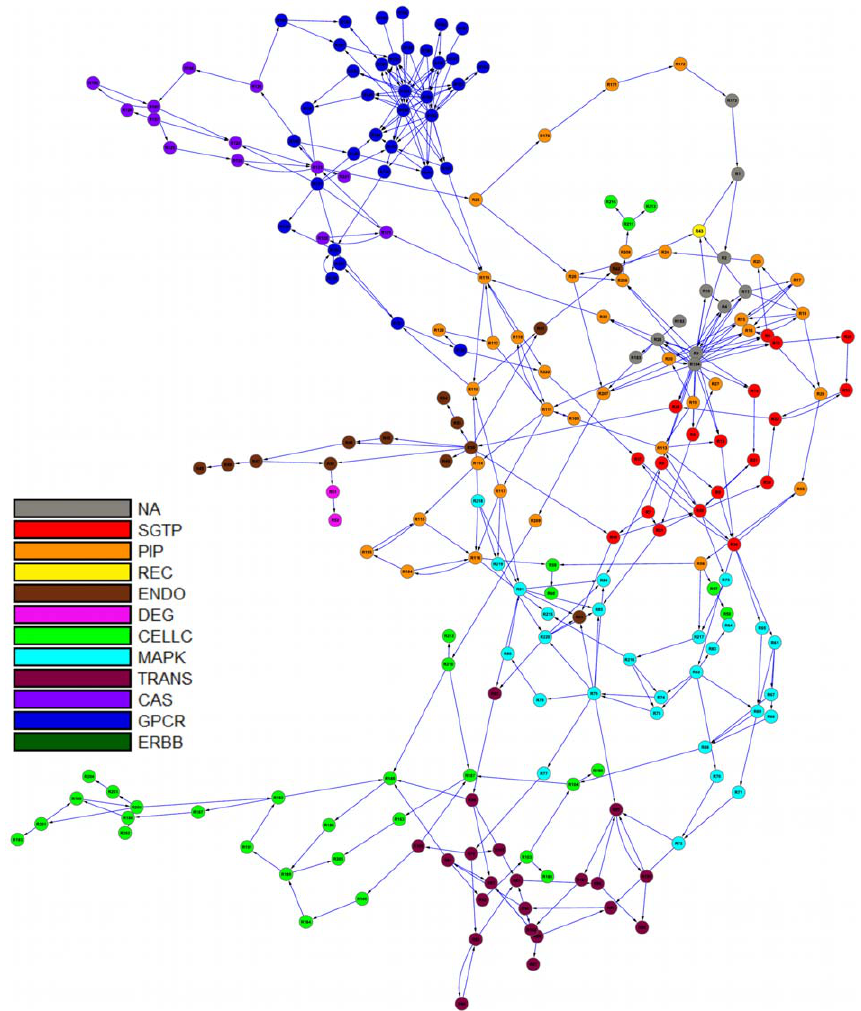
Figure 1. Graph image of the signaling network. Each reaction in the network was a priori assigned to one of 11 canonical signaling pathways as described in Methods. The pathway assignments are indicated by the color of the reaction vertex in the network. (NA: not assigned; SGTP: small guanosine triphosphatase mediated signaling; PIP: phosphatidylinositol polyphosphate signaling; REC: recycling; ENDO: endocytosis; DEG: degradation; CELLC: cell cycle; MAPK: mitogen-activated protein kinase cascade; TRANS: transcription; CAS: Ca 2 + signaling; GPCR: G-protein coupled receptor mediated signaling; ERBB: erythroblastic leukemia viral oncogene homolog receptor signaling).